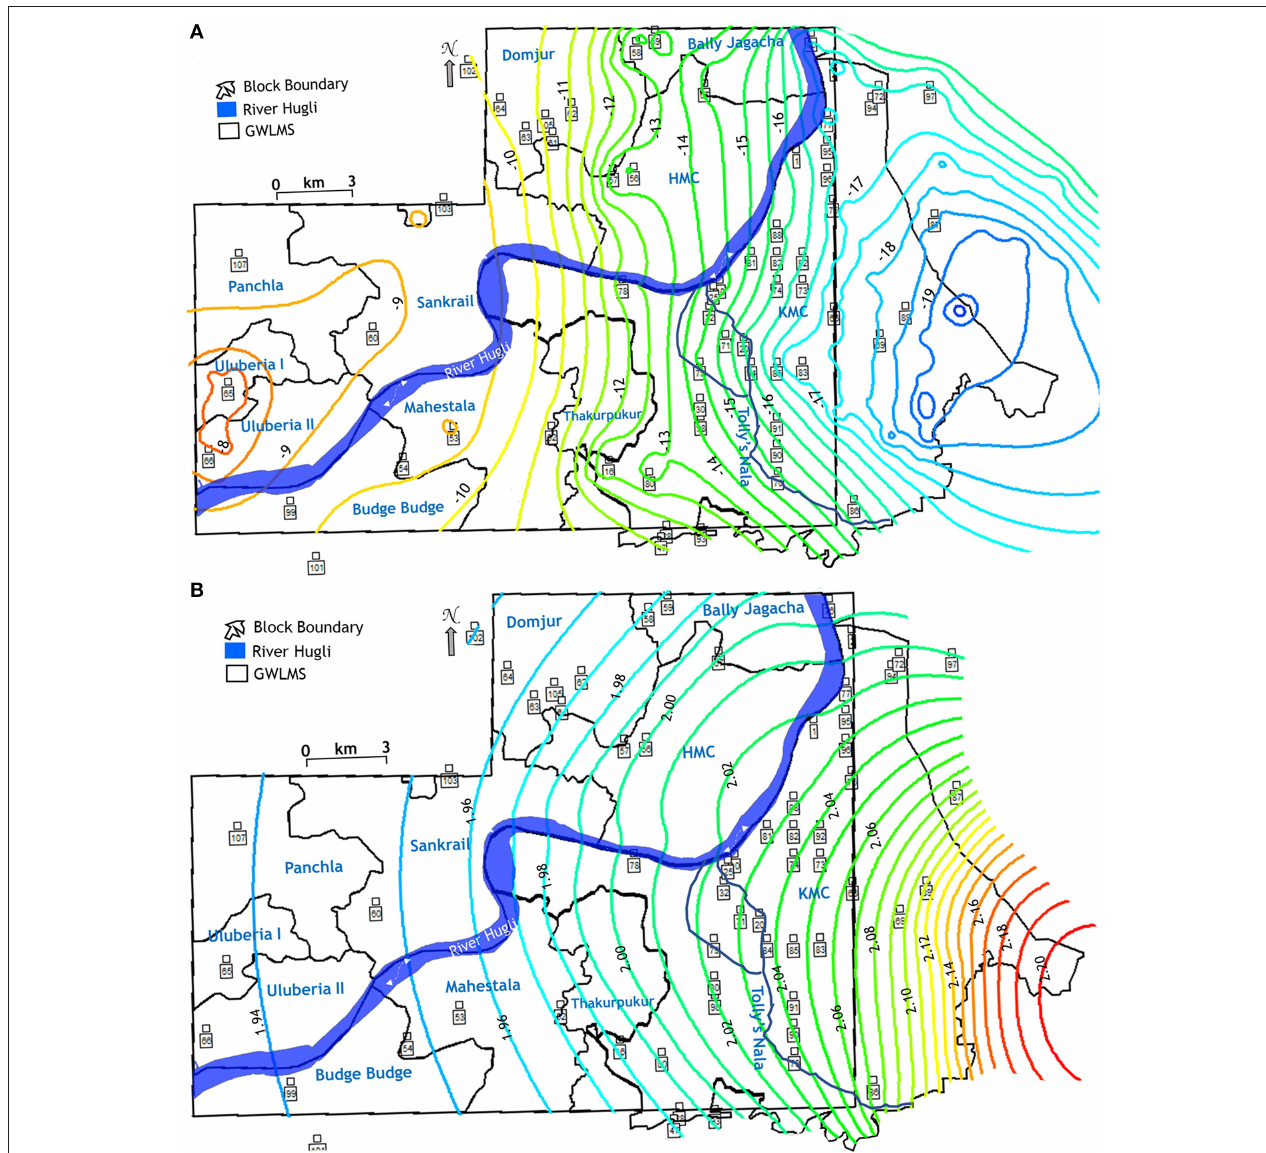
FIGURE 9 | (A) Spatial distribution of heads (depth: 100–120m) of the study area under future development (2030) condition. (B) Spatial distribution of drawdown (depth: 100–120m) with respect to present development of the study area under future development (2030) condition.